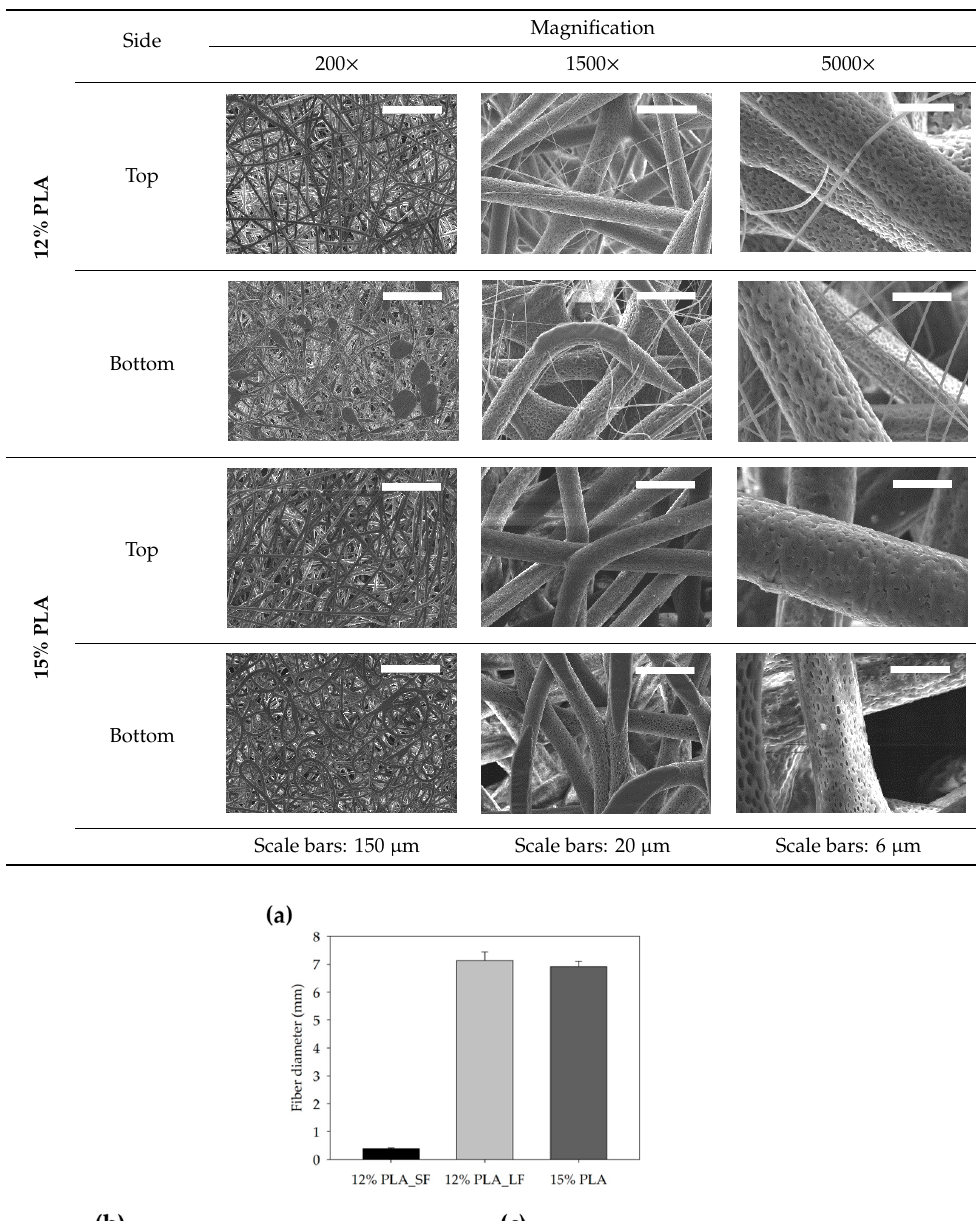
Table 4. Microscopic characterization of 12% and 15% electrospun (ES)-PLA scaffolds (7 kV, 5 mL/h). Micrographs from the top and bottom sides at different magnifications were visualized using SEM.